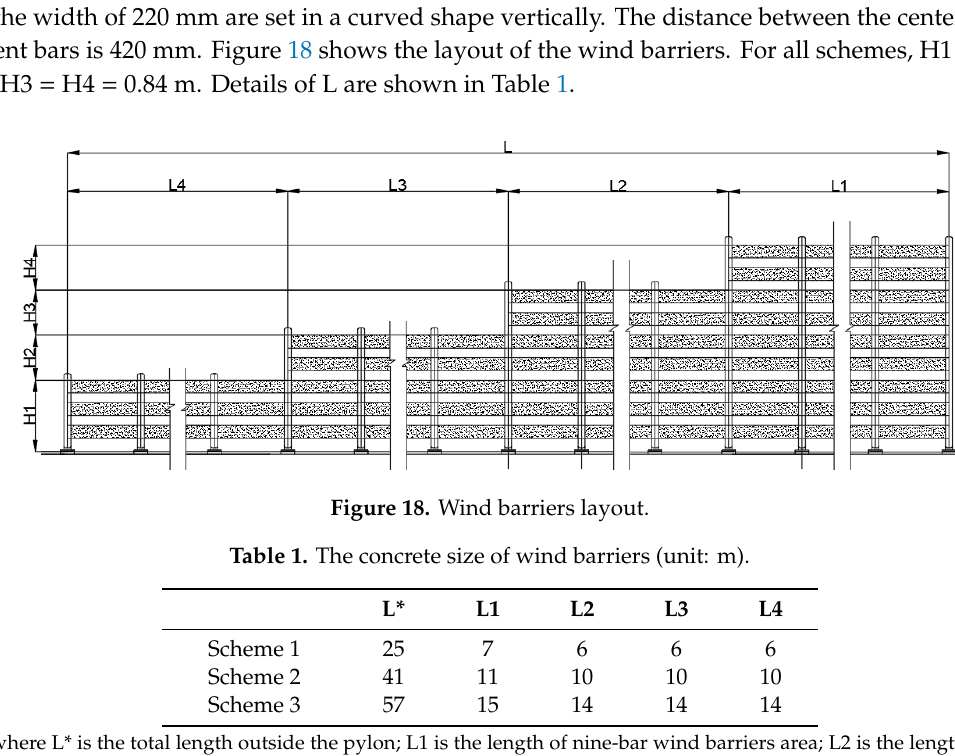
Table 1. The concrete size of wind barriers (unit: m).